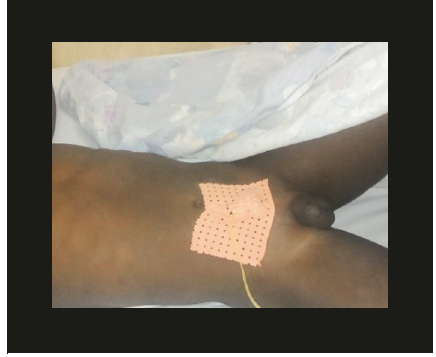
Figure 8: Suprapubic cystostomy in place (case 2).